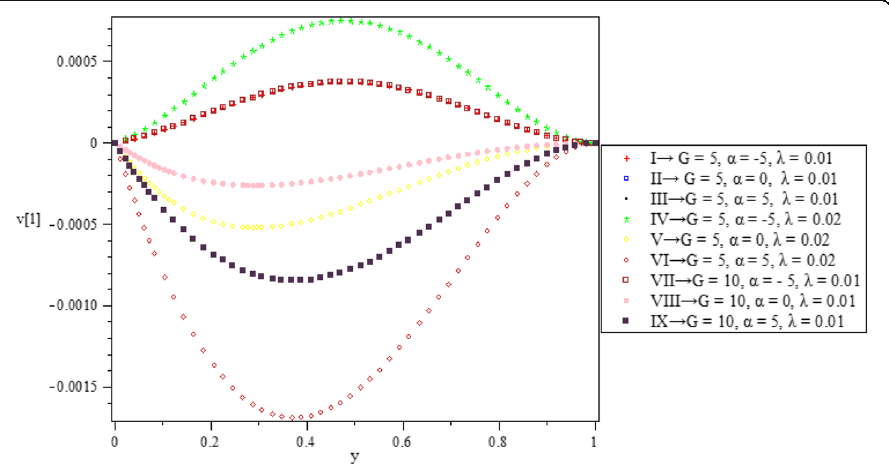
Fig. 22 First-order velocity (v[1] profile, r = − 1, ϵ = 0.25, P = 7, and β =